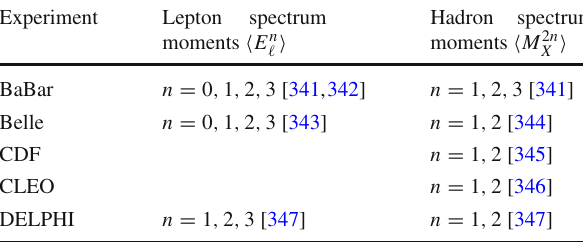
Table 5 List of available measurements of inclusive moments in B → X c (cid:4)ν . We also specify the types of the lepton energy E (cid:4) and hadronic mass M ( X c ) spectrum moments which have been determined in